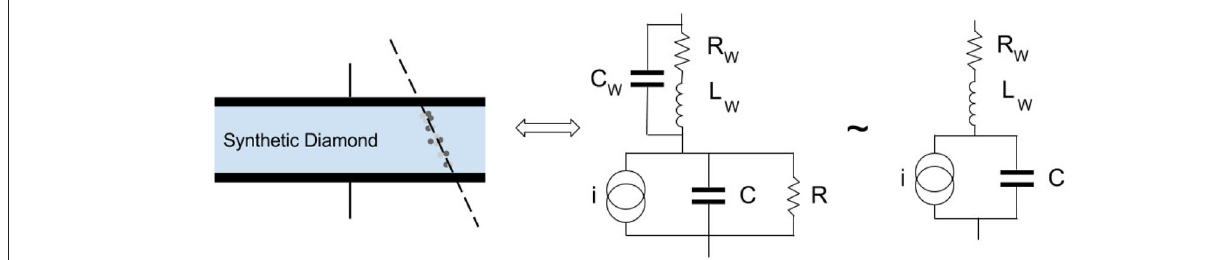
FIGURE 3 | Equivalent model of a diamond detector with parallel plate geometry.